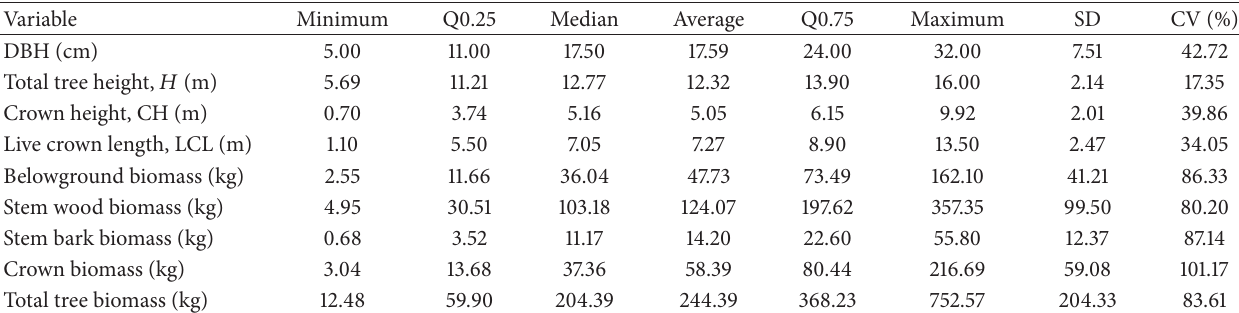
Table 1: Summary statistics for the independent and dependent